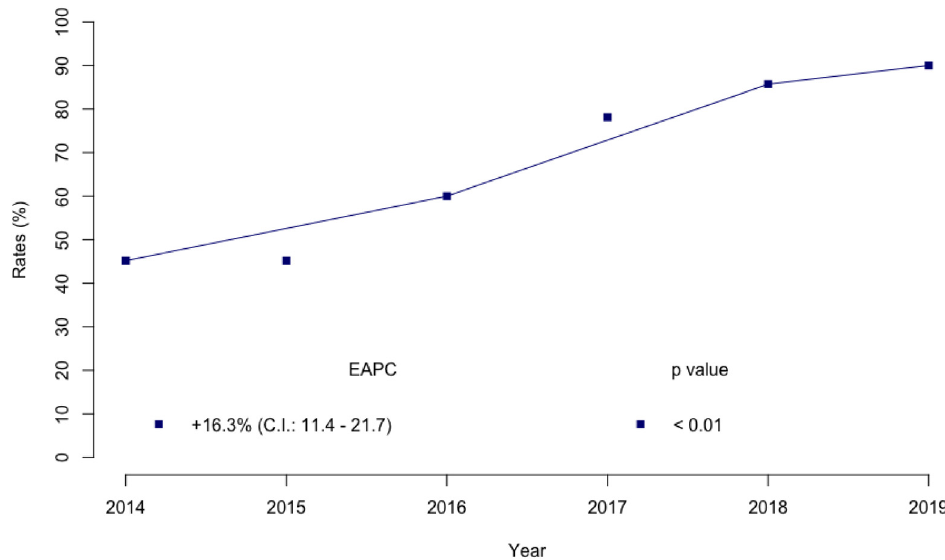
Figure 3. Trend of annual rate change of RARC with orthotopic ileal neobladder reconstruction. Table 1. Preoperative and intraoperative outcomes of 30 patients with non-metastatic bladder cancer treated with robot-assisted radical cystectomy and Shell-shape ileal ortothopic neobladder